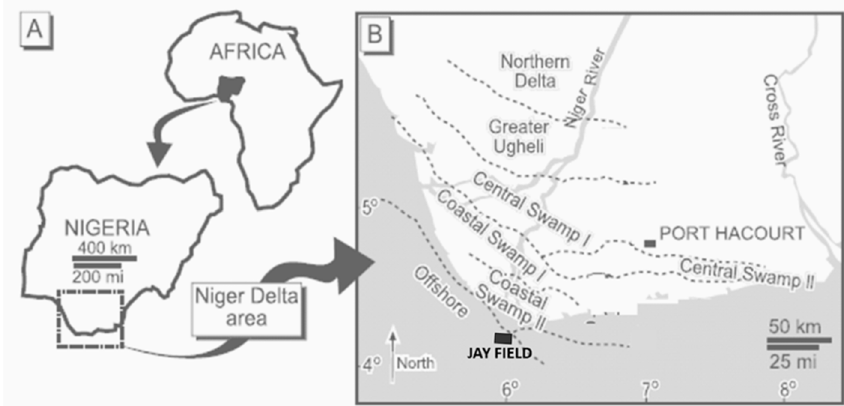
Fig. 1 A Map of the Niger Delta. B Various depobelts and locations of the study area (Jay Field)